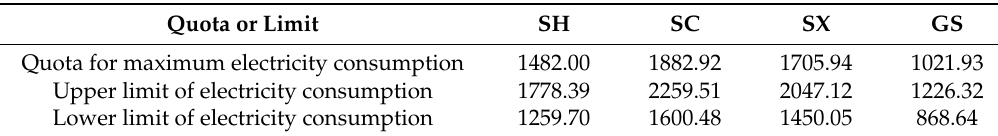
Table 10. Quotas and limits of electricity consumption in 2014 (10 8